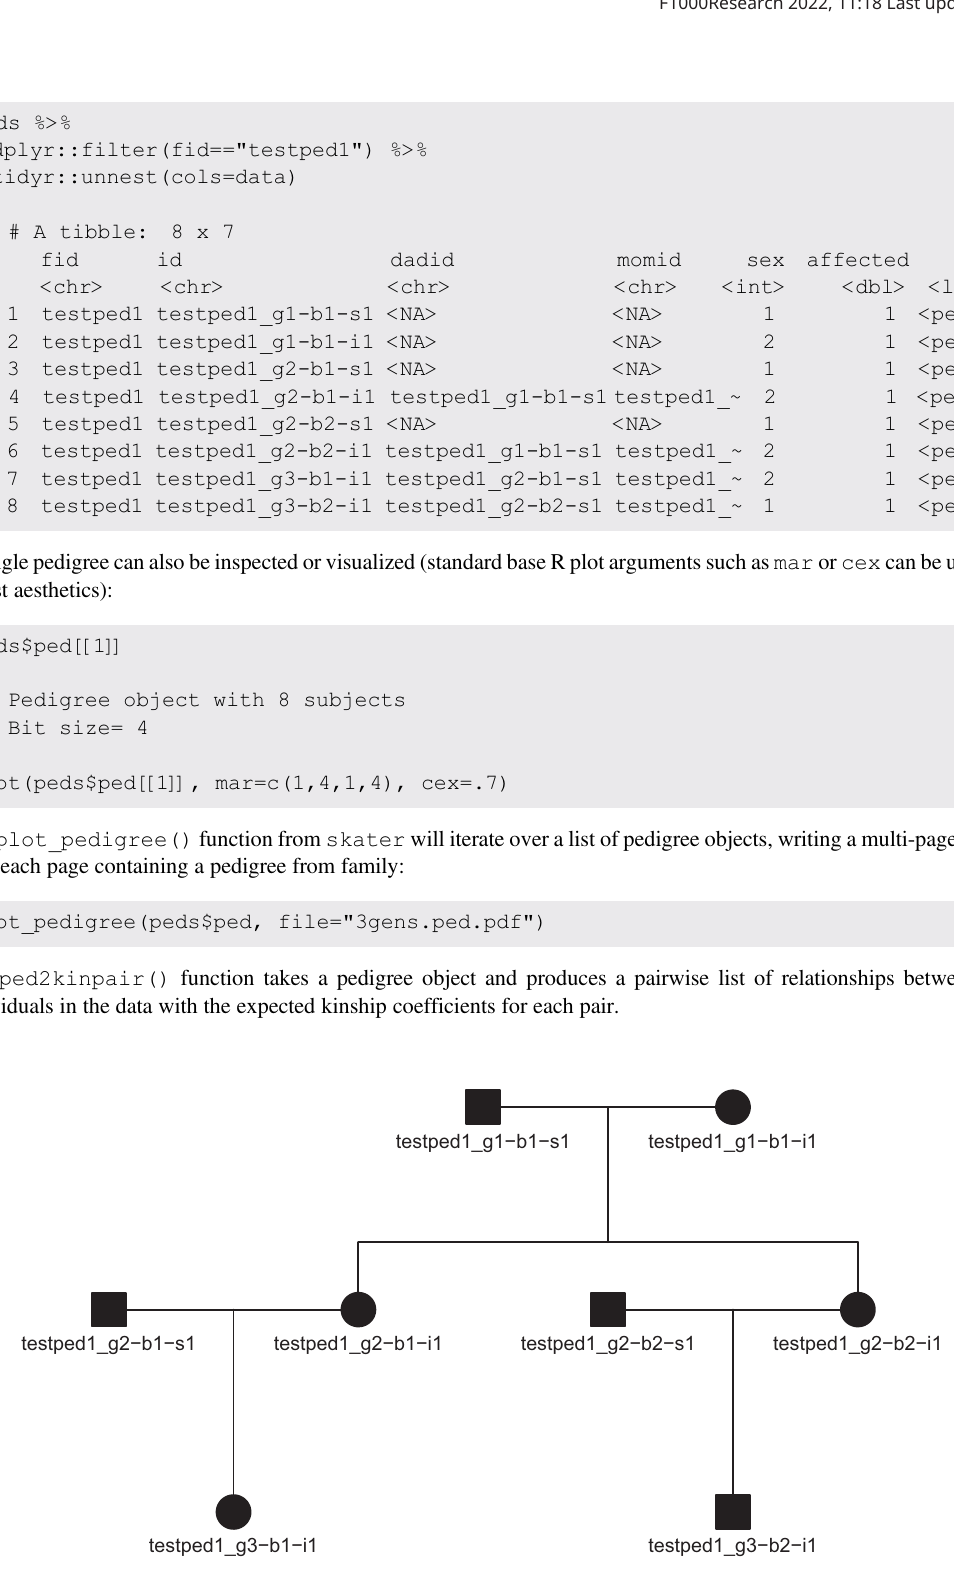
Figure 1. Pedigree diagram for the first family in the pedigree shown in the code